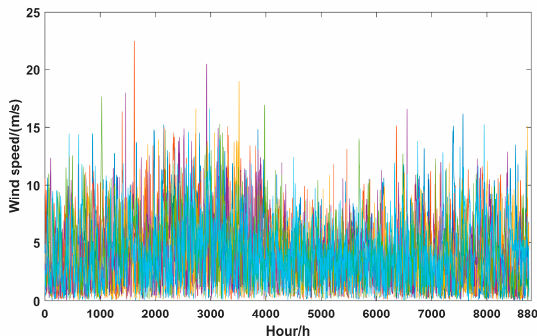
Figure A3. Measured windspeed in eastern Mongolia.